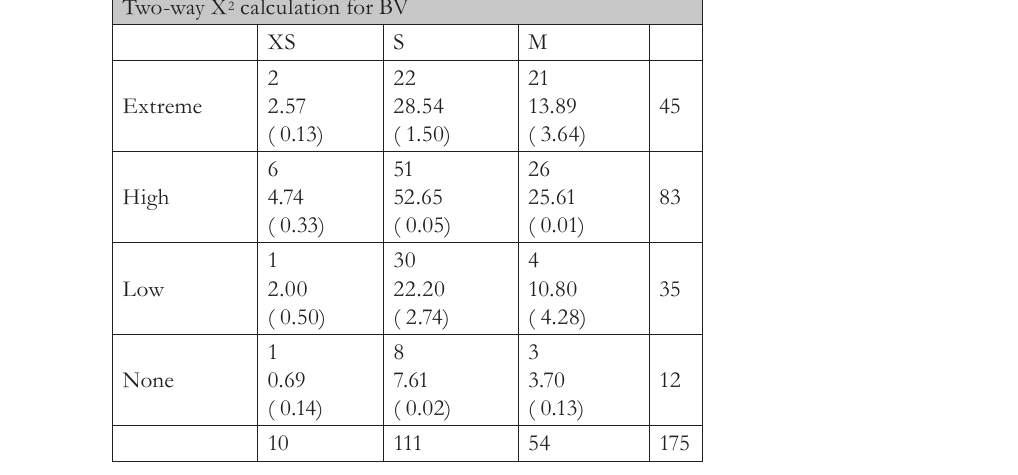
Tab. 6 – Search for independence between BV and company size. Source: own research Two-way X 2 calculation for